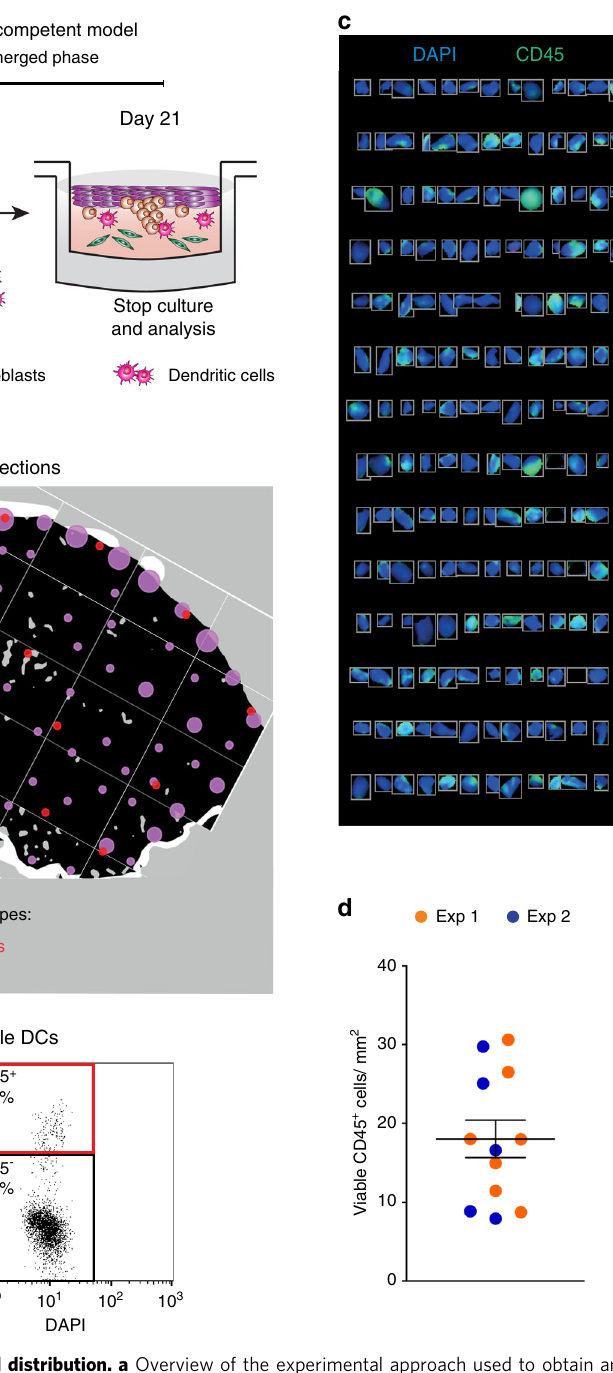
Fig. 2 The OMC microenvironment sustains immune cell survival and distribution. a Overview of the experimental approach used to obtain an immunocompetent OMC. b Tissue classi fi cation and DC localization within the selected ROI. Coloured dots indicate distribution of immune (red) and other cell types (pink), based on tissue segmentation and positivity score (upper panel, 1); cytometric image analysis and gating strategy to identify viable DCs (DAPI + Cleaved-Caspase-3 − CD45 + events) (lower panel, 2). c Viable cDC2s as a result of the gating strategy visualized in the original image, showing a representative selection of gated events. DAPI (blue), CD45 (green). d Quanti fi cation of viable, immune cells/mm 2 in at least 5 sections per construct, wherein colours indicate two independent experiments. Source data are provided as a Source data fi